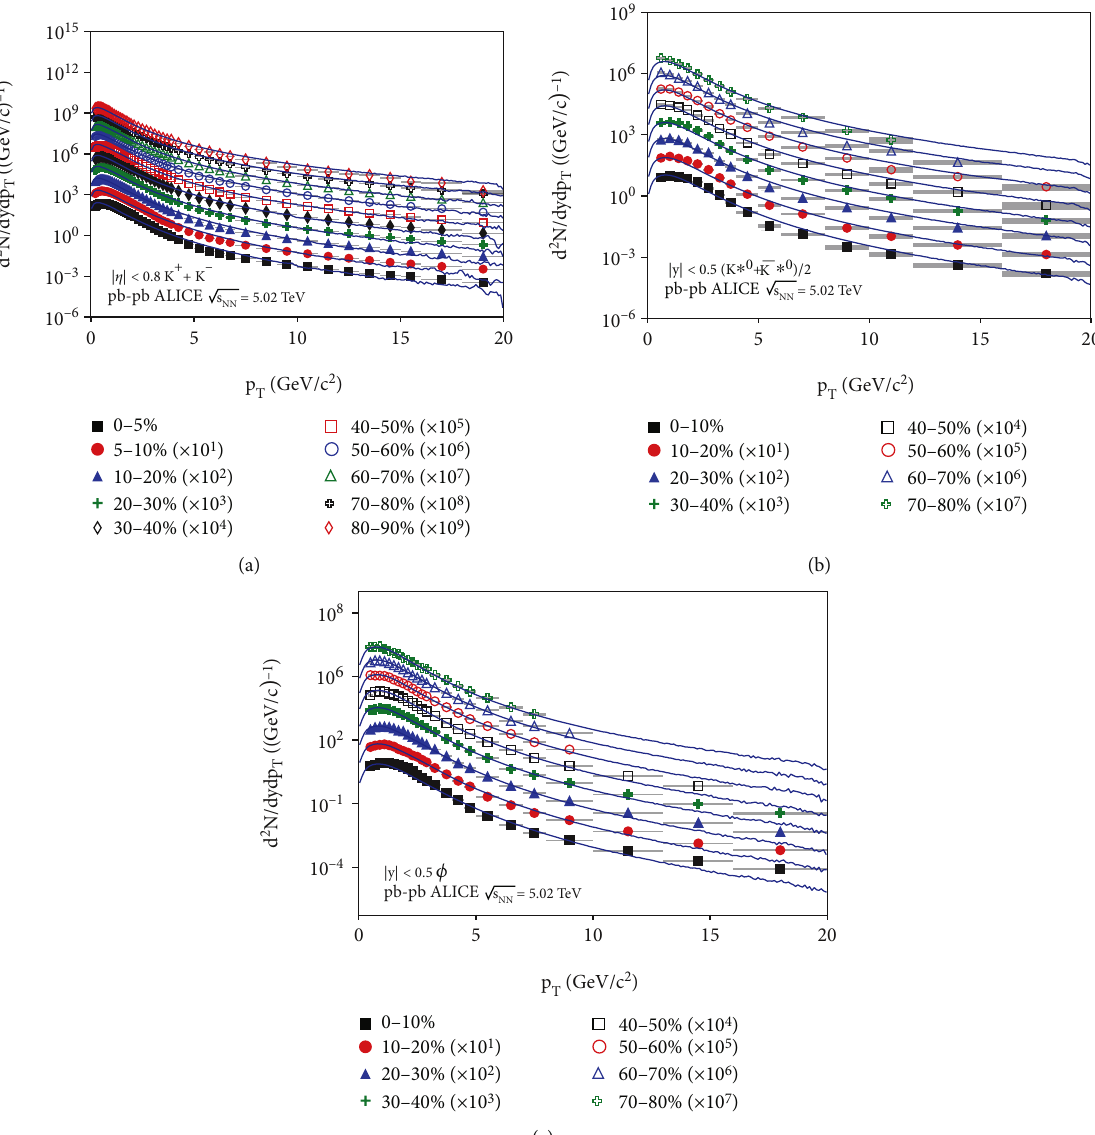
p ffiffiffiffiffiffiffi = 5 : 02 TeV. The symbols represent the s NN